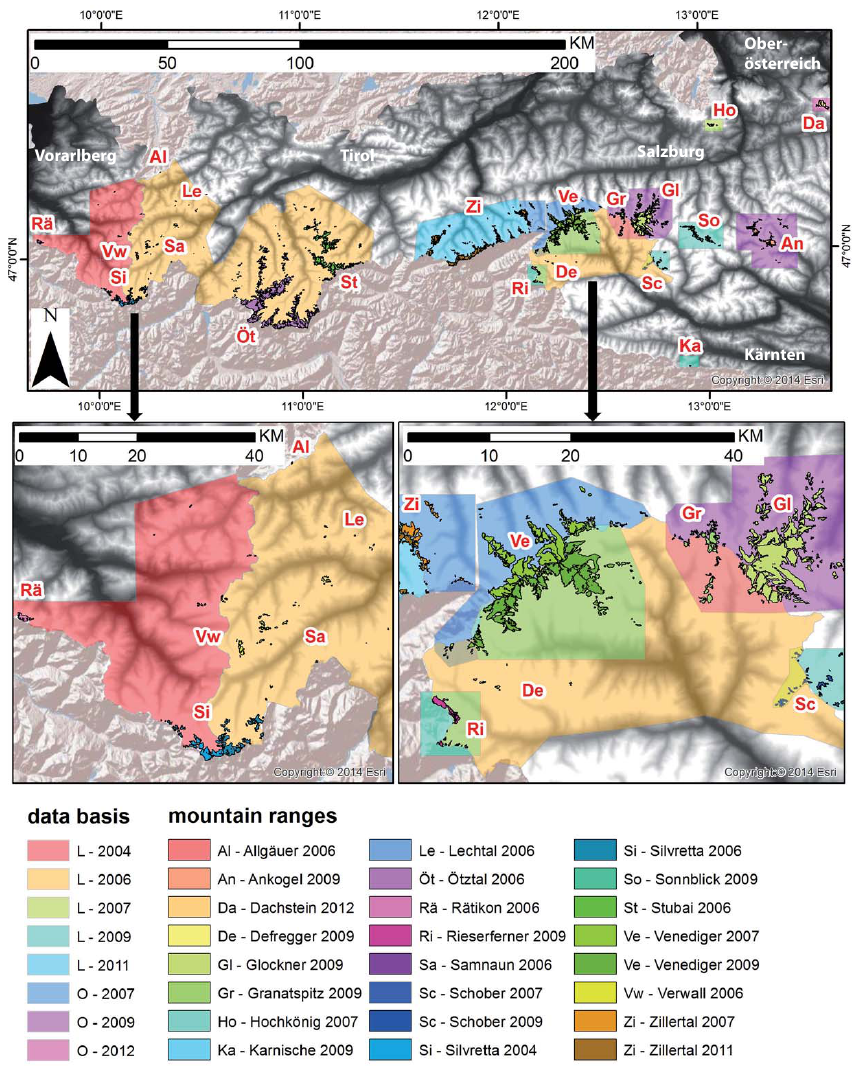
Figure 1. Austrian glaciers colour-coded by mountain ranges, with polygons showing data type and date used for deriving GI 3 and GI LIA (Mountain ranges and survey dates can also be found in Fischer et al. (2015).